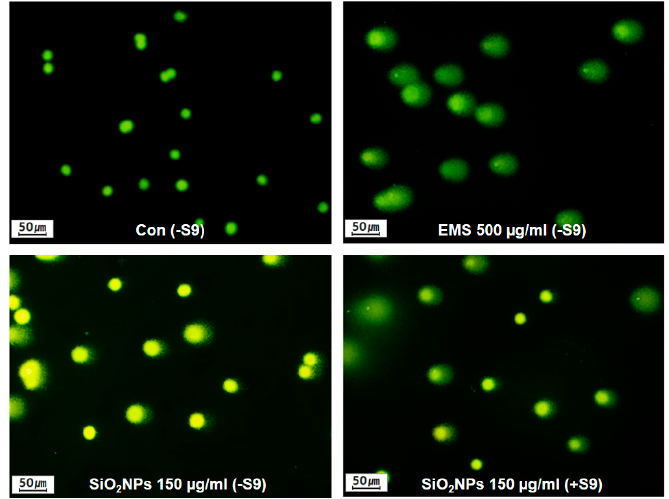
Figure 3. Effects of SiO 2 NPs on DNA damage in CHL cells. Representative in vitro comet assay after the treatment with 150 μ g/mL SiO 2 NPs or 500 μ g/mL ethyl methanesulfonate (EMS) for 24 h in the absence of S9 mix and 150 μ g/mL SiO 2 NPs for 4 h in the presence of S9 mix.